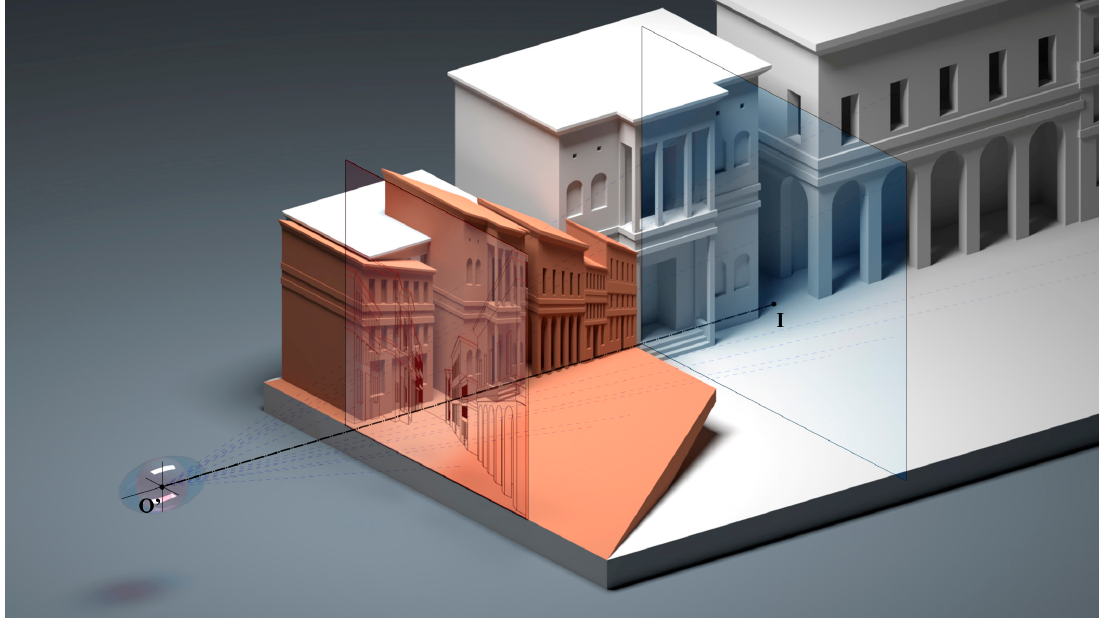
Figure 6. Hypothesis on the size of the restricted sight in case of a linear